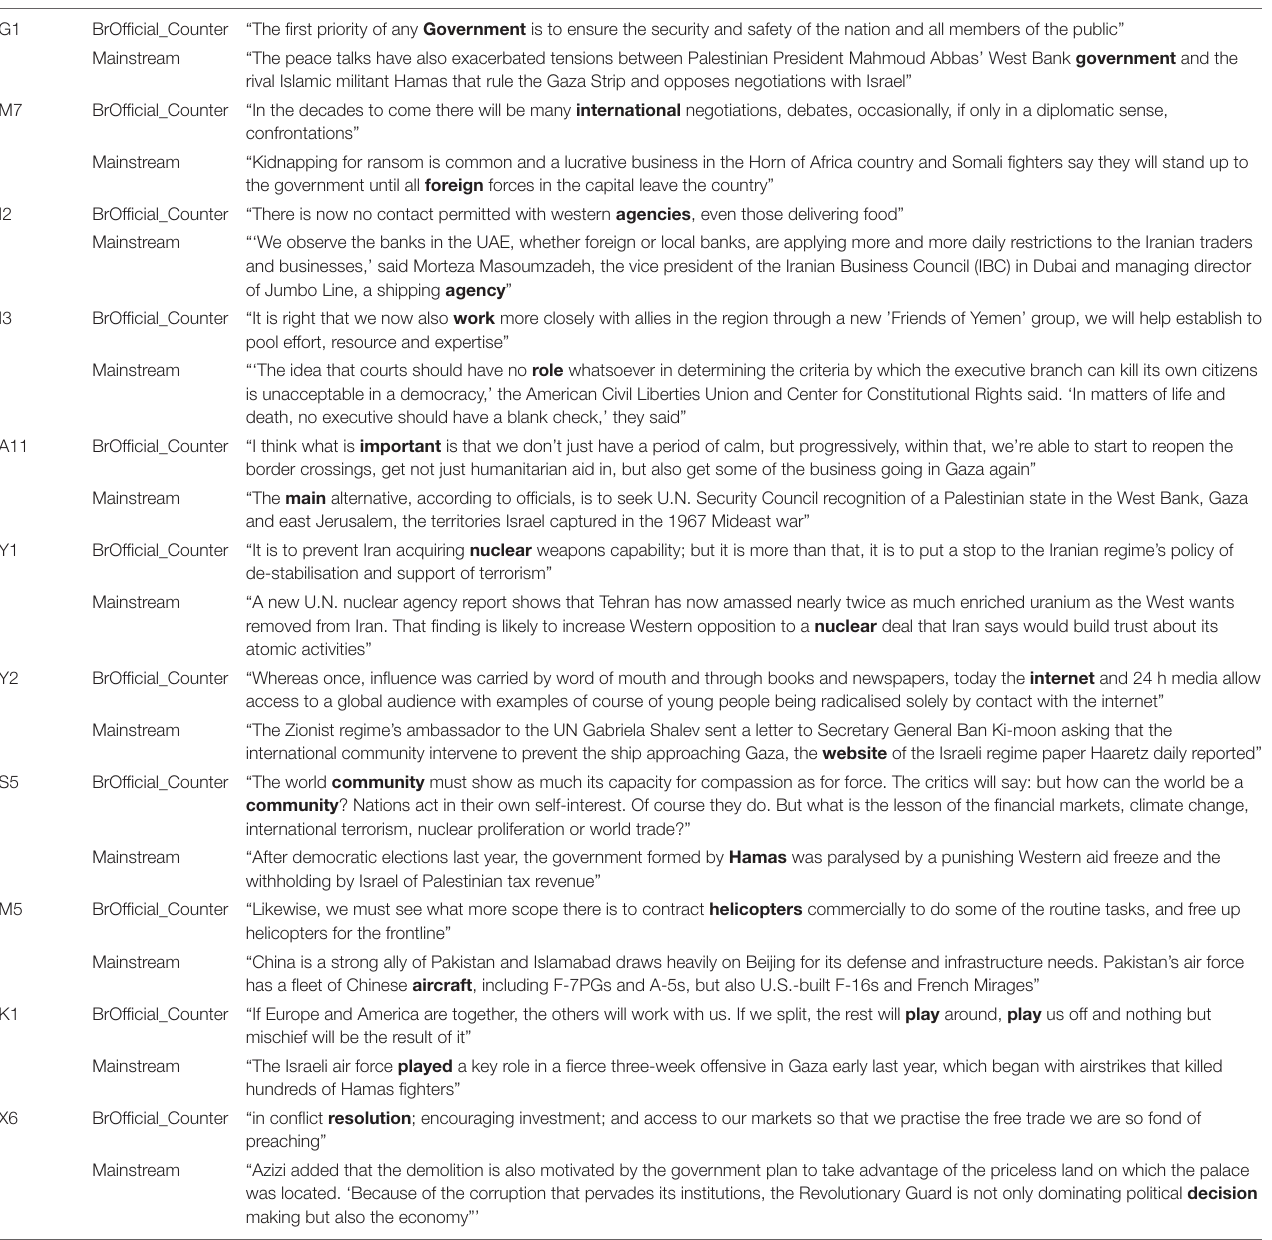
TABLE 4 | Examples of shared conceptual categories between British Official authored counter-extremist messages (BrOfficial_Counter) and Arab mainstream media messages (Mainstream). Category